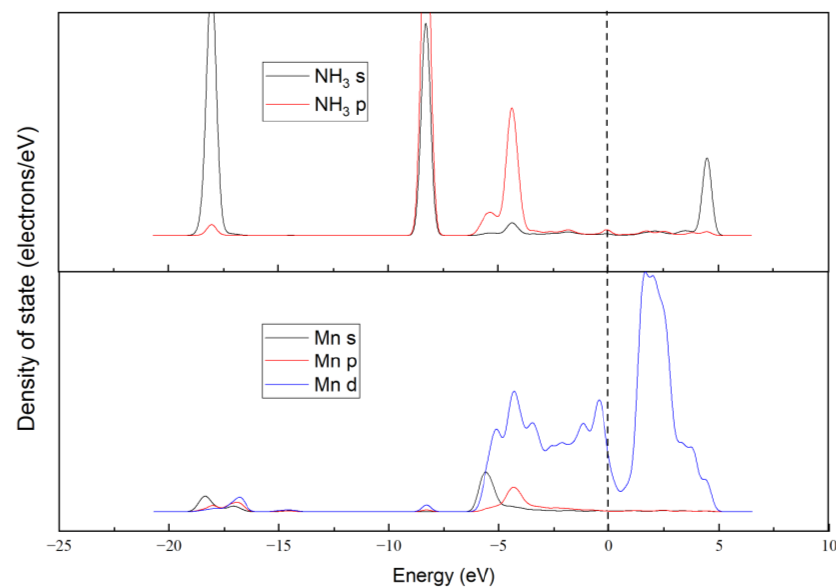
Figure 3. The partial density of state for NH 3 adsorption configuration.